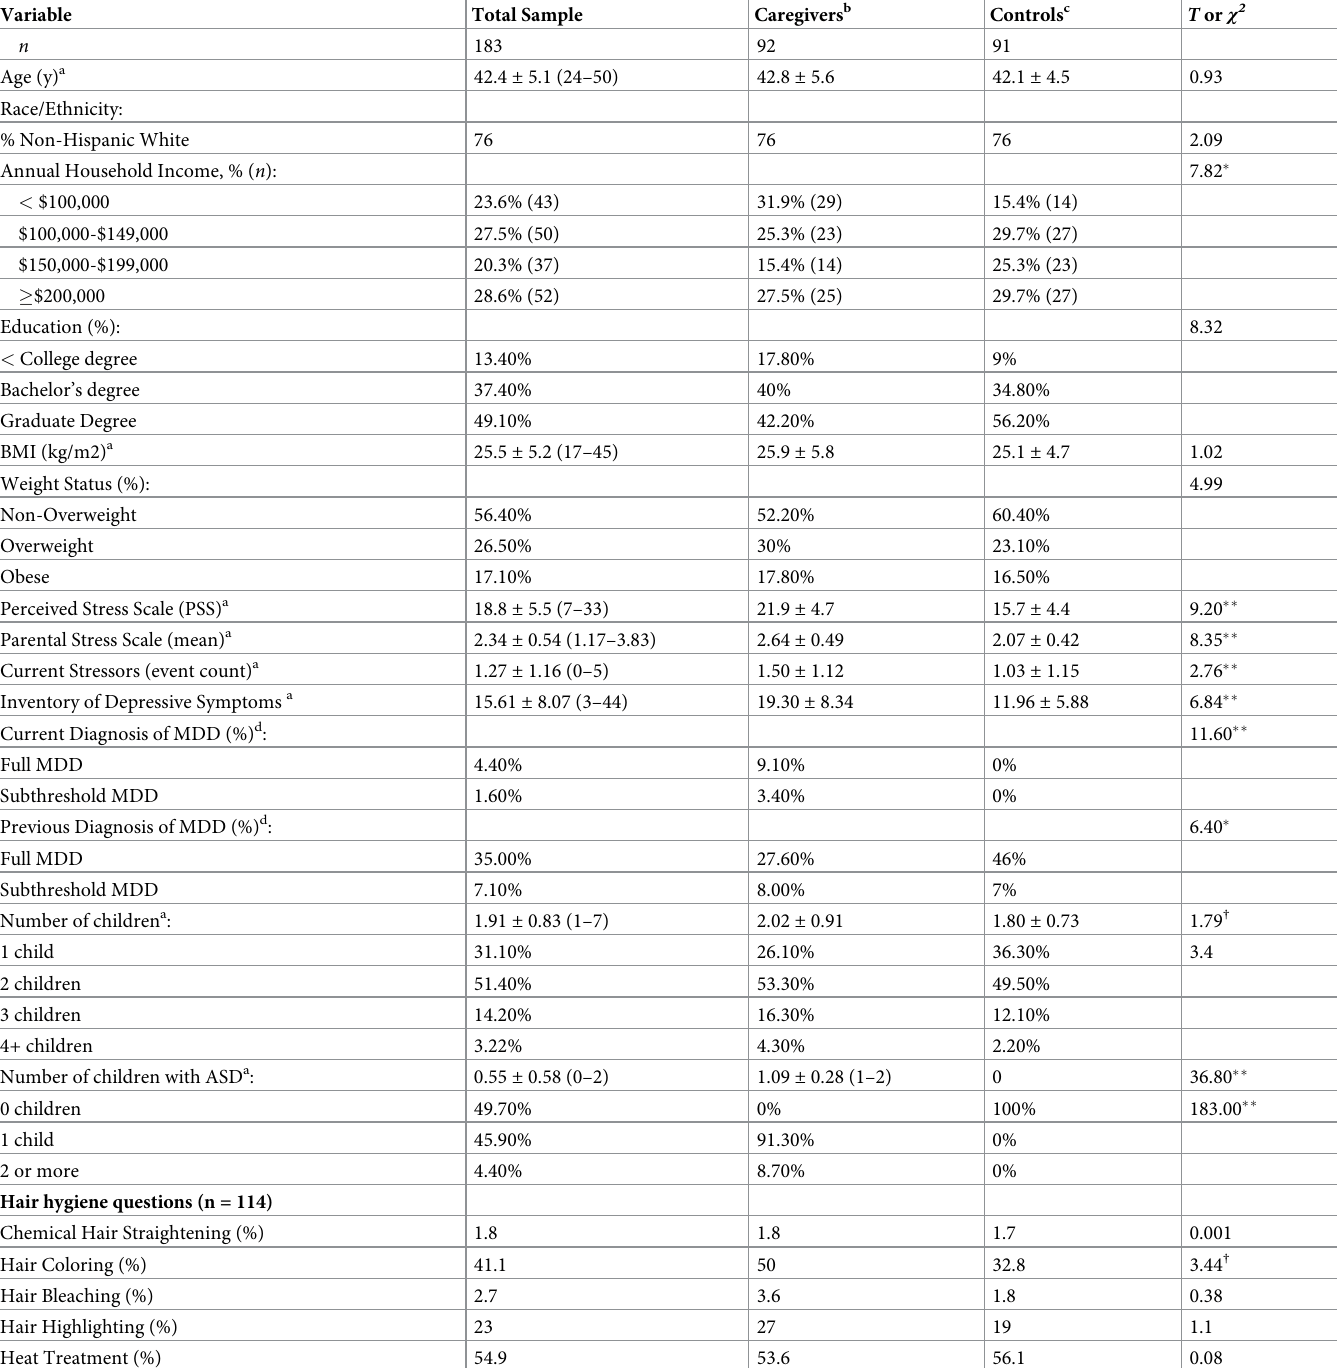
Table 1. Demographic and anthropometric characteristics of study participants at